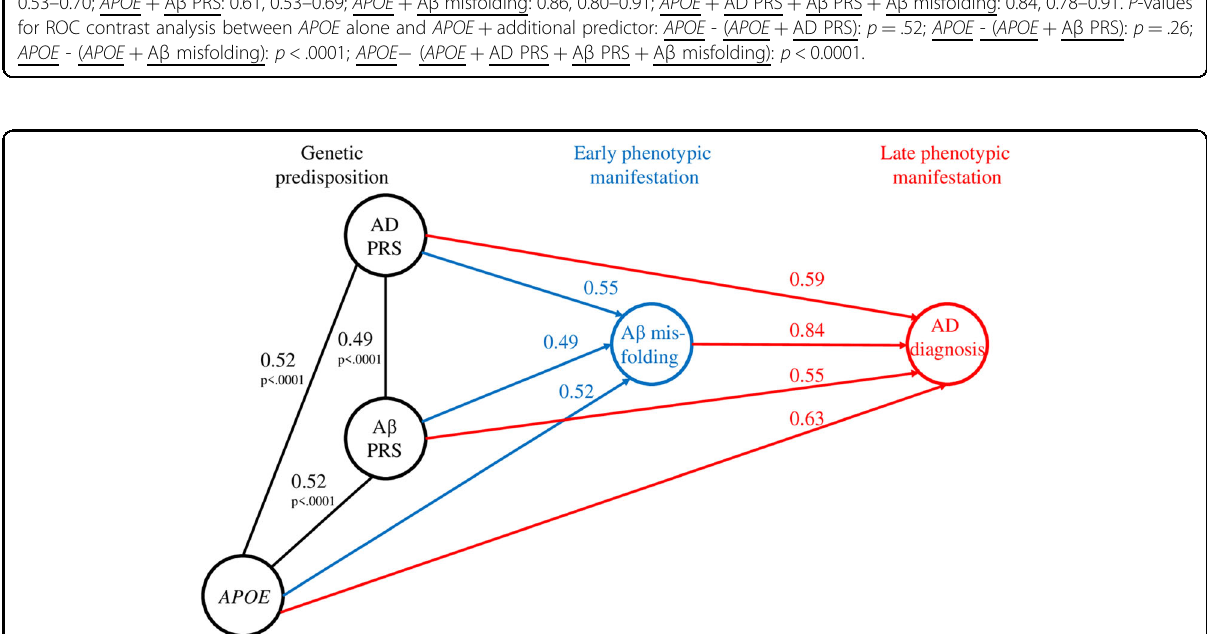
Fig. 3 Overarching relationship between the genetic risk markers, A β misfolding, and AD diagnosis measured in area under the curve (AUC) values (shown in blue and red) and Spearman correlation coef fi cients (shown in black). The prediction of A β misfolding by the genetic risk markers and AD diagnosis by the genetic risk markers and A β misfolding is expressed as AUC values and the relationship between genetic risk markers is expressed as Spearman correlation coef fi